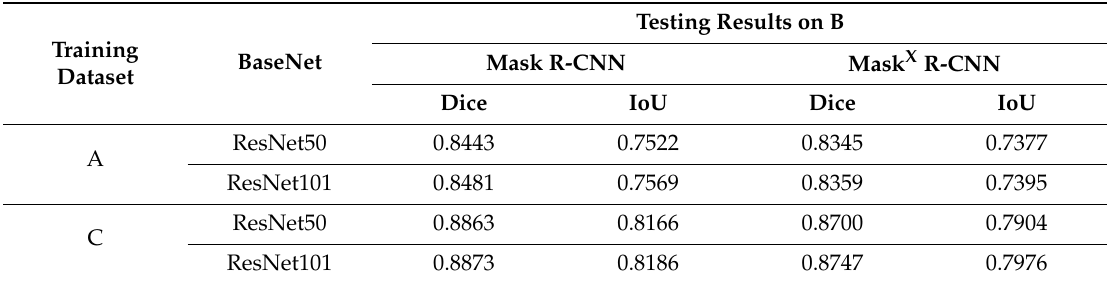
Table 4. Results for training on dataset A or C and testing on dataset